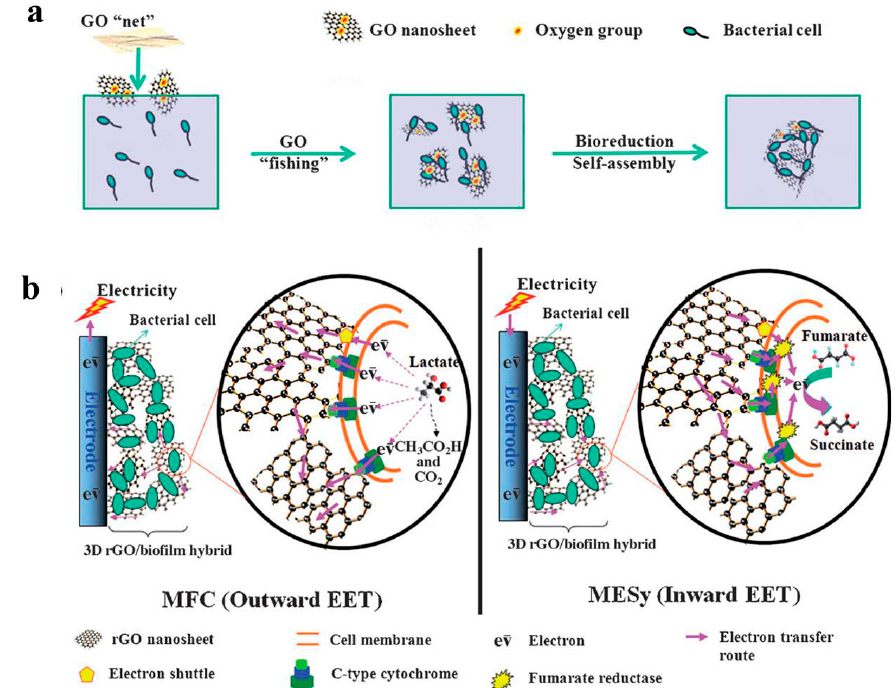
Figure 10. Schematic of ( a ) self-assembly of the 3D macroporous rGO/bacteria hybrid biofilm by a fishing process; ( b ) the proposed mechanism of bidirectional EET [115]. Reproduced with permission from Wiley.